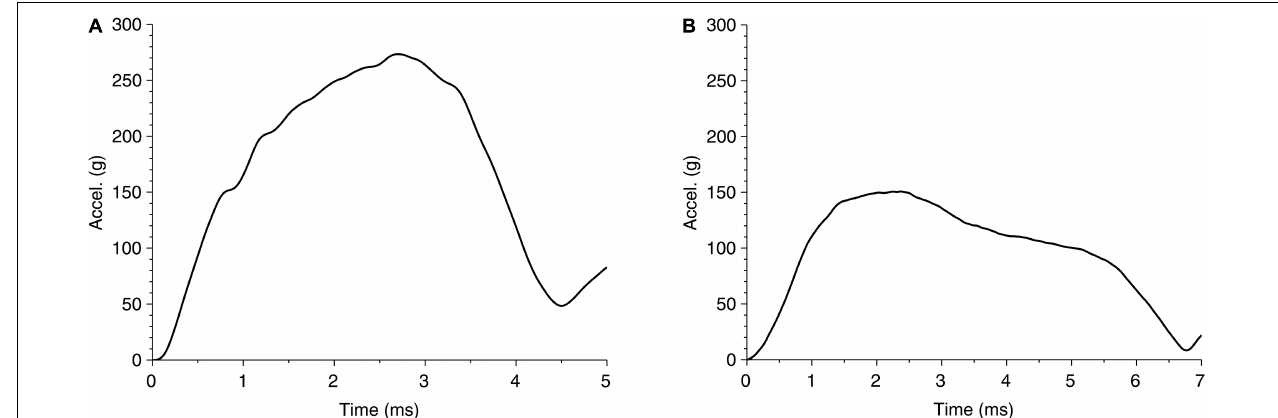
FIGURE 6 | Time history of head acceleration during impact of head due to fall for (A) case 1 and (B) case 2.